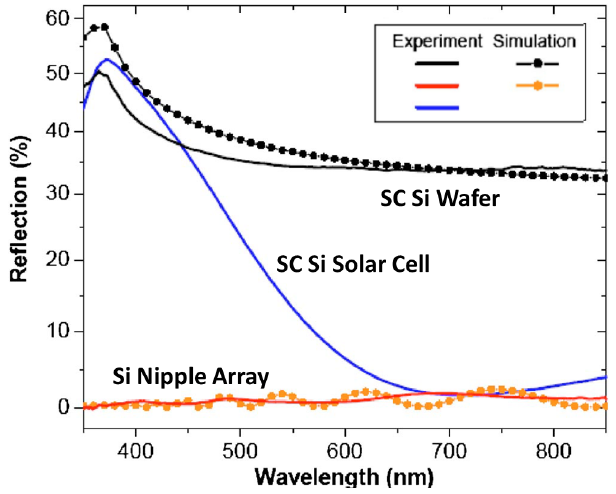
Figure 25. Experimental and simulated results from flat (black) and etched nipple array (red) show good agreement for the RCWA method. Blue line is an experimental value from a commercial c-Si solar cell. Reprinted with permission from reference [81], Copyright 2008 AIP Publishing.